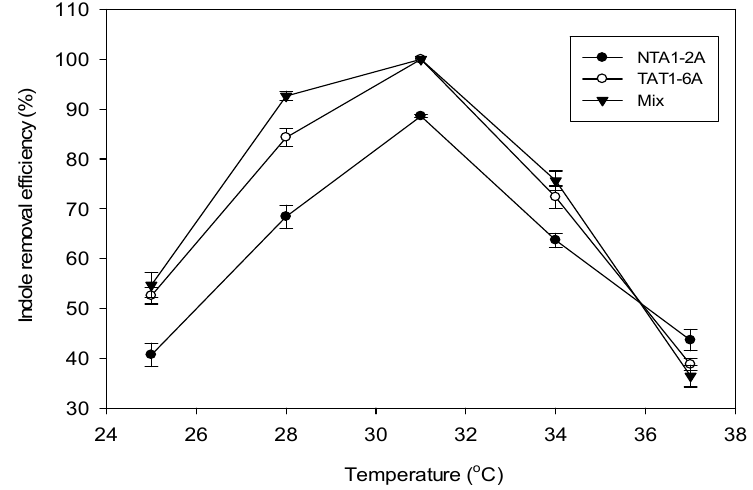
Figure 4. Effect of temperature on indole removal efficiency (%) at pH 6 and 117.15 mg/L (1.0 mM) of indole concentration incubated for 96 h. Error bars: Mean ± SE of three replicates. E ff ect of pH: Indole degradation using the two strains was also a ff ected by the pH of the culture media solutions. Both strains and the mix exhibited maximum indole degradation e ffi ciency (%) at pH 6. Strain TAT1-6A and the mix showed increased indole degradation e ffi ciency between pH 6 and 7 (Figure